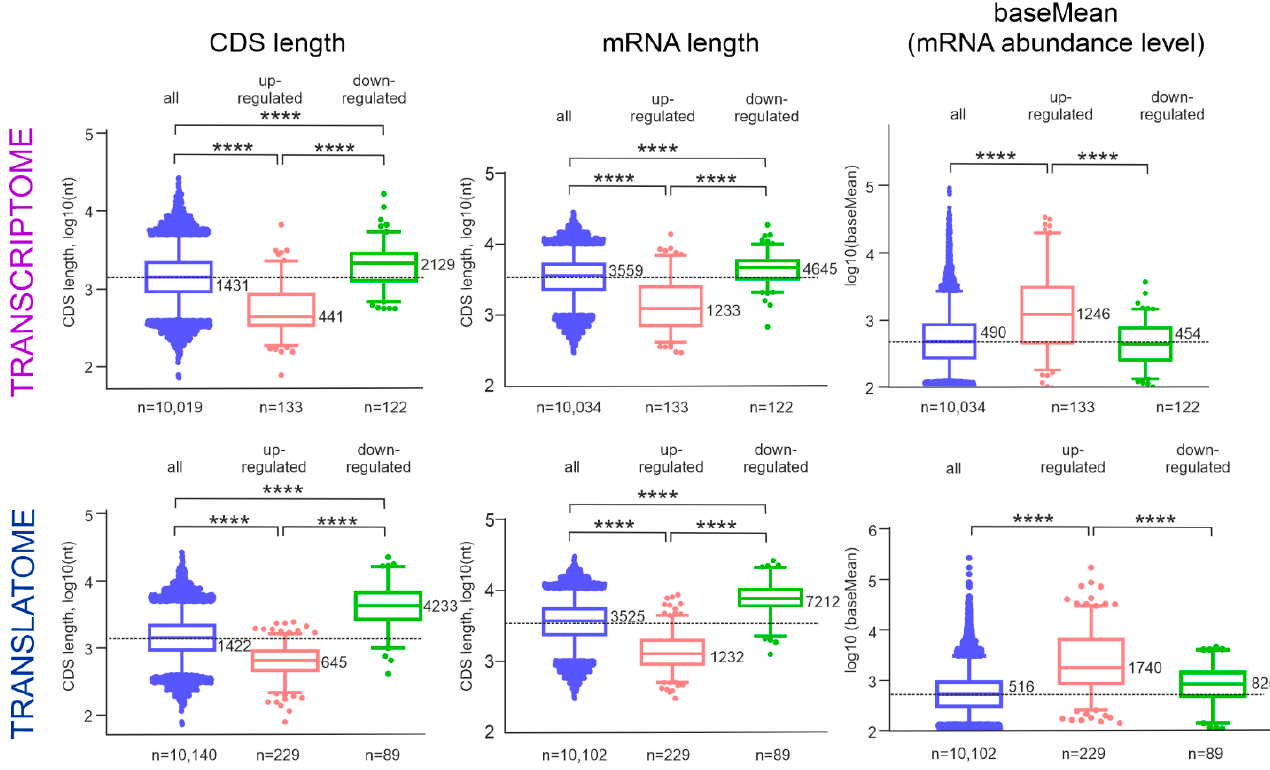
Figure 5. Length and abundance of the up-regulated and down-regulated DEG mRNAs. Data on the CDS and mRNA lengths and the mRNA abundance levels (baseMean) are presented in columns, and data for tDEGs and pDEGs are presented in rows. Each graph contains three box-and-whiskers plots showing the distribution of up-regulated tDEGs or pDEGs (rose), down-regulated tDEGs or pDEGs (green) and for all sequenced genes (blue) by the length of their CDSs or mRNAs, or by base mean. The boxes represent the 25th percentile, median (values are designated on the right of boxes), and 75th percentile, and whiskers indicate the 5–95% range; **** p < 0.0001.